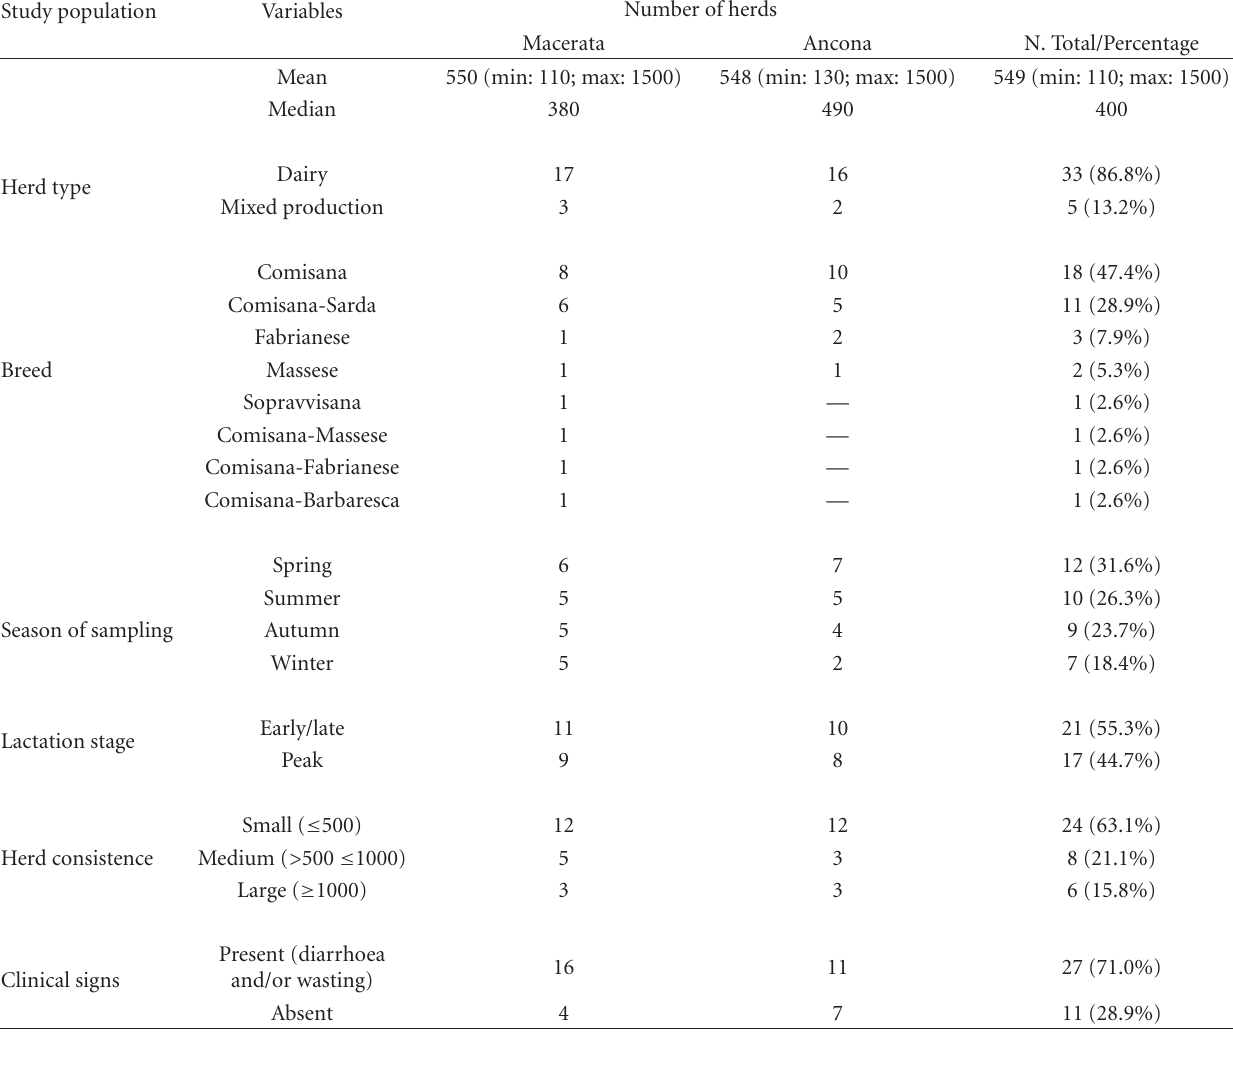
Table 2: The sheep population in the evaluated herds in Ancona and Macerata provinces.